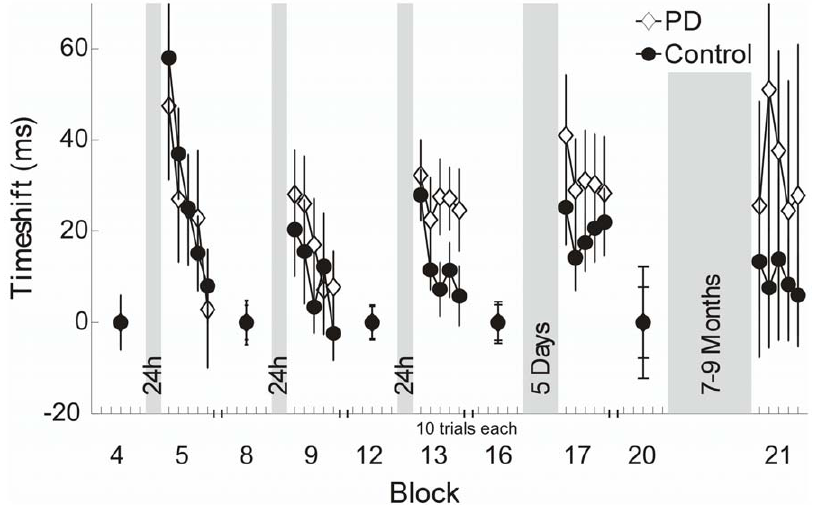
Figure 7. Group averaged timeshift measure quantifying release control. Average timeshift for the last block of a session and the first block of the subsequent session for patients and the control group. Note that timeshift values after breaks are displayed in five series of ten trials to illustrate change with continued practice. Error bars denote standard error of the mean.